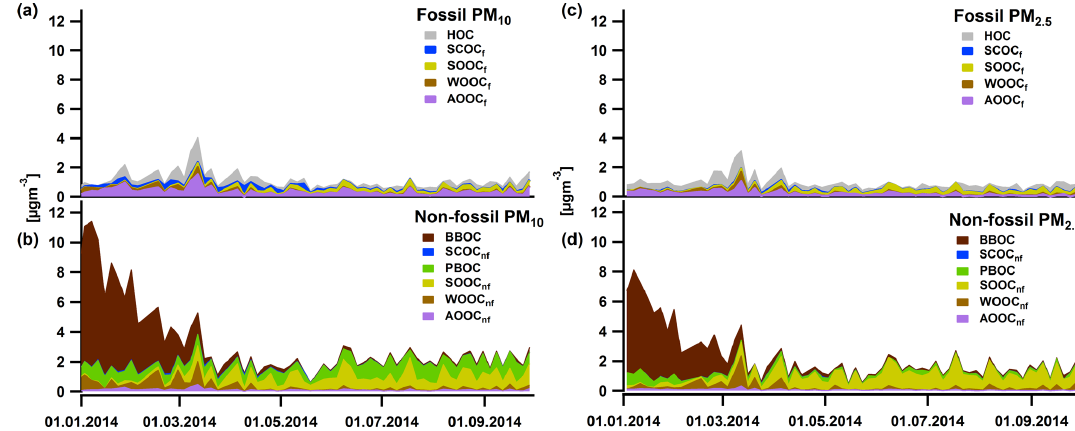
Figure 10. Yearly cycles of fossil PM 10 (a) , non-fossil PM 10 (b) , fossil PM 2 . 5 (c) , and non-fossil PM 2 . 5 (d) OC factors: BBOC in dark brown, SCOC f and SCOC nf in blue, PBOC in green, AOOC f and AOOC nf in purple, SOOC f and SOOC nf in yellow, and WOOC f and WOO nf in light brown. Note that the covered time periods in (a) , (b) and (c) , (d) are different.